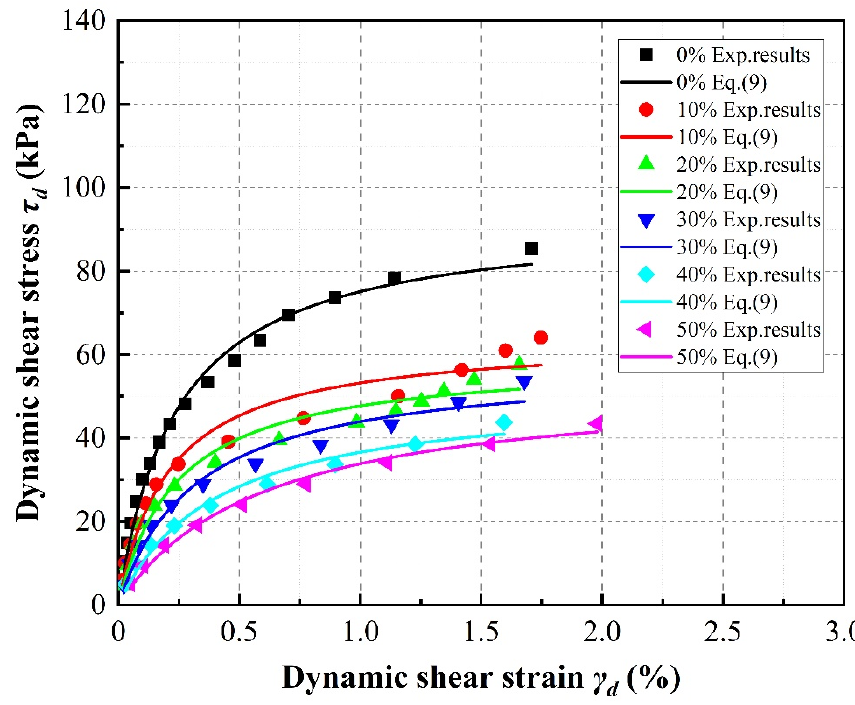
Figure 6. E ff ect of rubber content on stress–strain relationships of SRP2 sand–rubber mixtures under 100 kPa confining pressure.